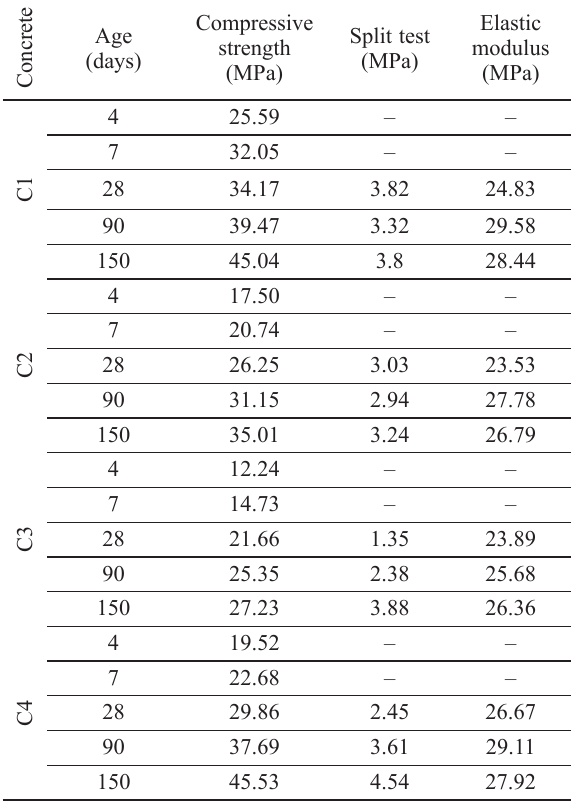
Table 4. Mechanical properties of mixtures under